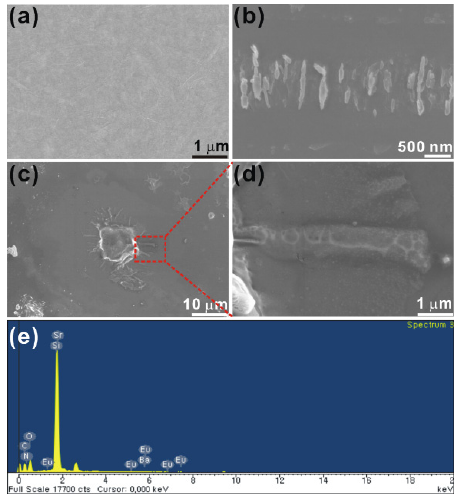
Figure 1. SEM images of ( a ) GO; ( b , c ) various regions of GNP1 film; ( d ) an expanded view of the single scroll shown in the red dotted square in ( c ); and ( e ) the EDAX spectra from the scroll. The AFM images of the GO and GNP1 films shown in Figure 2a,b also confirm the formation of nanoscrolls in GNP1 films. Figure 2c,d show TEM images of the GO and GNP1 films, and the inset figures show the corresponding selected area electron diffraction (SAED) patterns. The SAED pattern of the GO film depicts the (002) reflections of the GO lattice [16]. The SAED pattern of the GNP1 film shows a mixed pattern of GO and CNT. Figure 2e,f show schematic diagrams of phosphor particles attached to GO sheets and completely scrolled sheets, respectively.